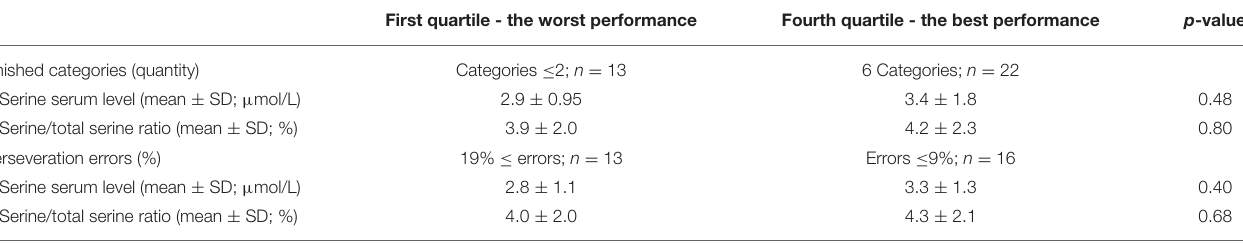
TABLE 6 | D -Serine serum levels and D -serine/total serine ratio—comparison of first and fourth quartiles of patients’ population ( n = 50) divided into groups according to performance in the WCST. First quartile - the worst performance Fourth quartile - the best performance p -value